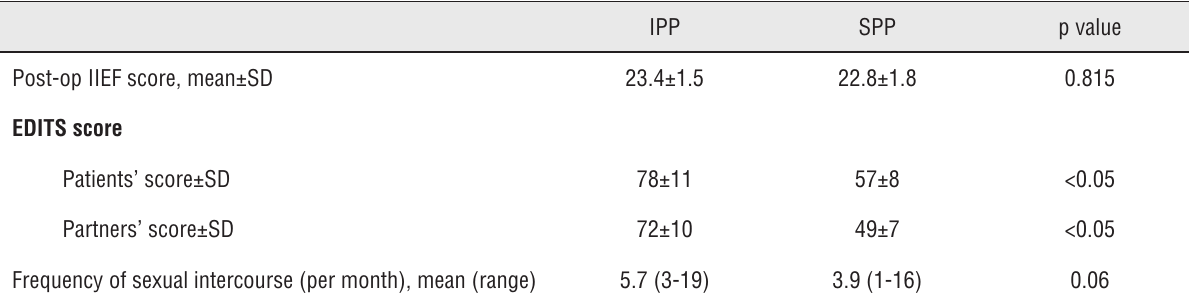
Table 3 - Satisfaction and outcomes of the